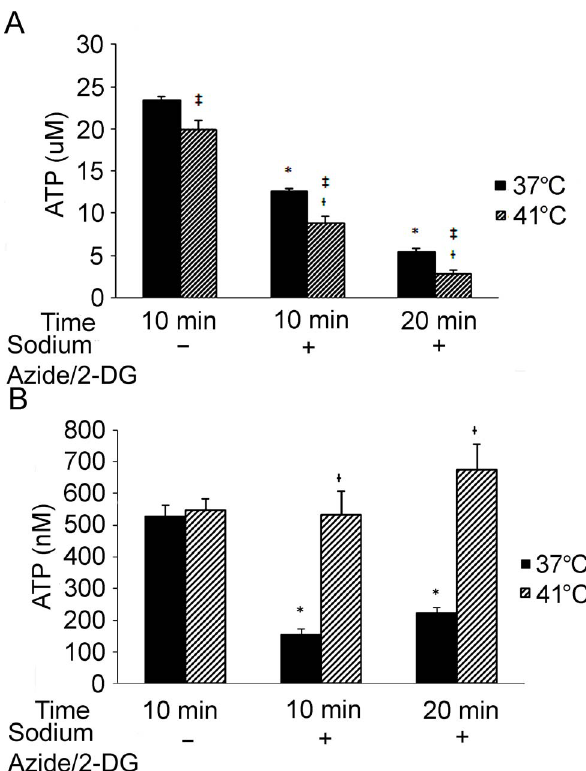
Figure 4. Intracellular and extracellular ATP levels changed following treatments. Neuronal death was induced by treating the cells with 0.5 mM 2-DG and 5 mM sodium azide for the indicated time. Control cells were incubated with fresh regular medium for 10 minutes. (A) Intracellular ATP was measured. Error bars represent mean 6 SEM. n=4. * denotes significant difference from 37 u C controls ( p , 0.01); { denotes significant difference from 41 u C control ( p , 0.01); ` denotes significant difference from the cells received the treatment at 37 u C ( p , 0.05). (B) Extracellular ATP was measured in the culture medium following the treatments. Error bars represent mean 6 SEM. n=4. *denotes significant difference from 37 u C controls ( p , 0.01); { denotes significant difference from the group received the treatment with sodium azide/2-DG at 37 u C ( p , 0.01).